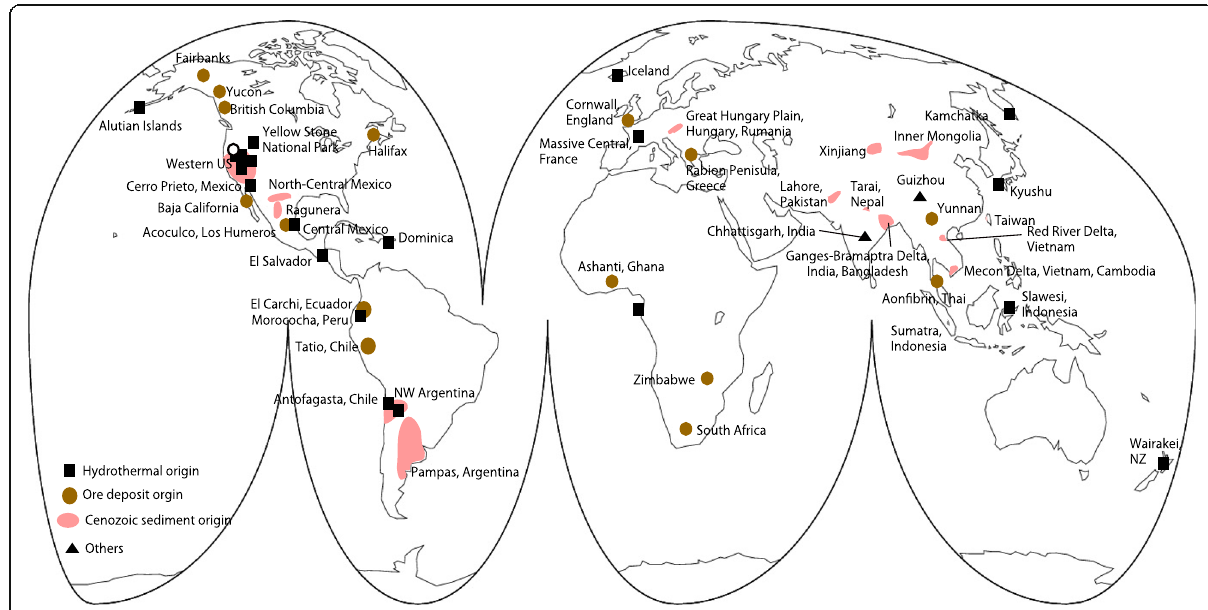
Fig. 2 World arsenic contamination map. This figure was produced based on the following reports and those in the text: Smedley and Kinniburgh (2002); Acharyya et al. (2005); An et al. (1997); Blanes et al. (2011); Camm et al. (2004); Gutiérrez-Caminero et al. (2015); Razo et al.